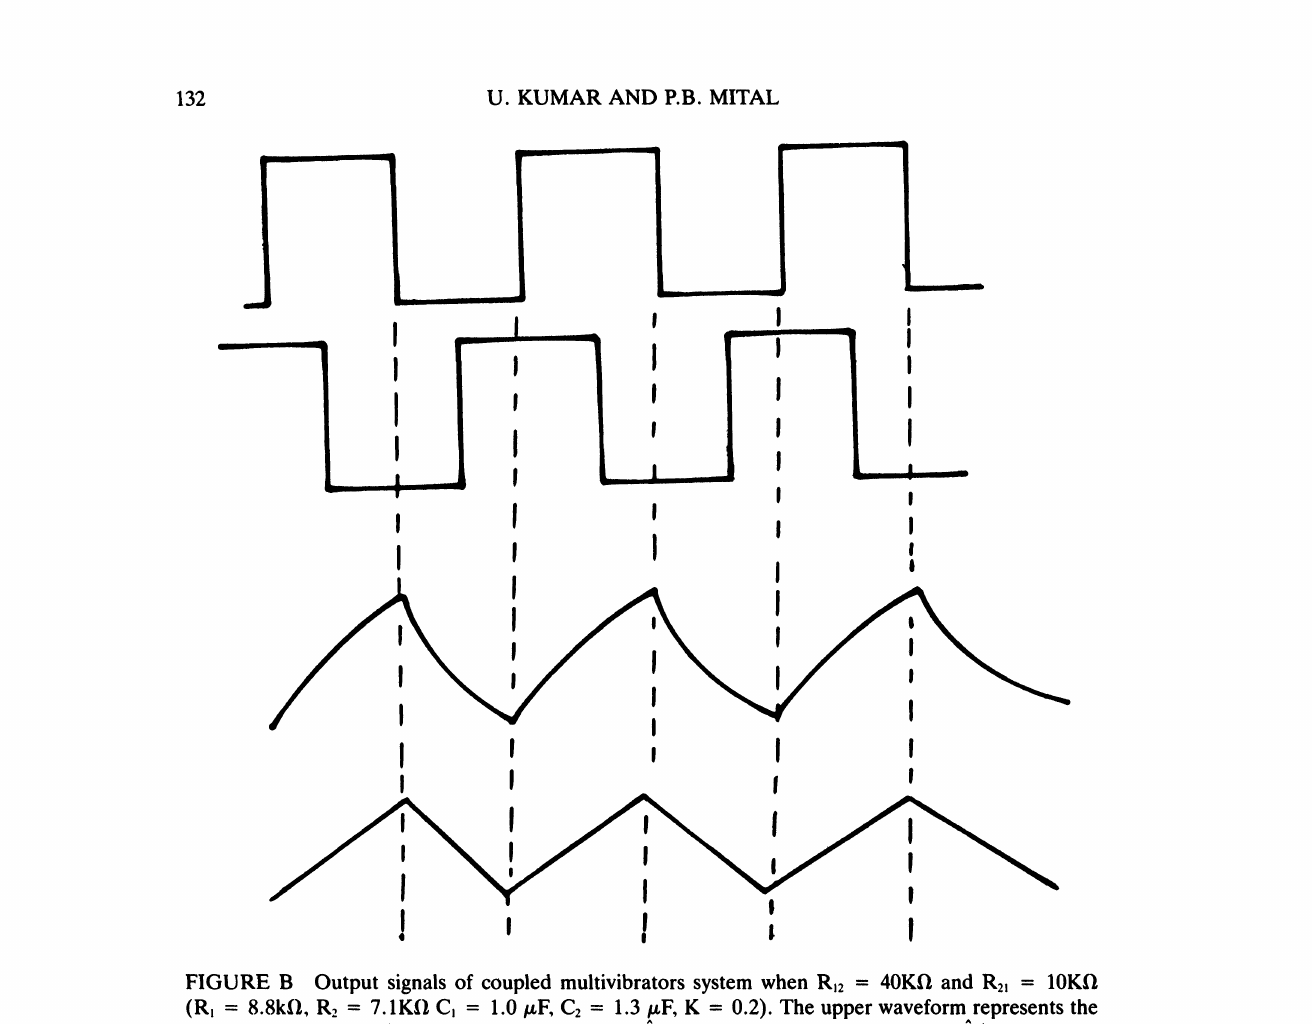
FIGURE B Output signals of coupled multivibrators system when Rl2 40Kf and R21 10KI) (R 8.8k1, R, 7.1KI! C 1.0/E C2 1.3/zE K 0.2). The upper waveform represents the square wave outputs (the upper trace represents and the lower trace represents 2). The lower waveform represents the Y outputs.